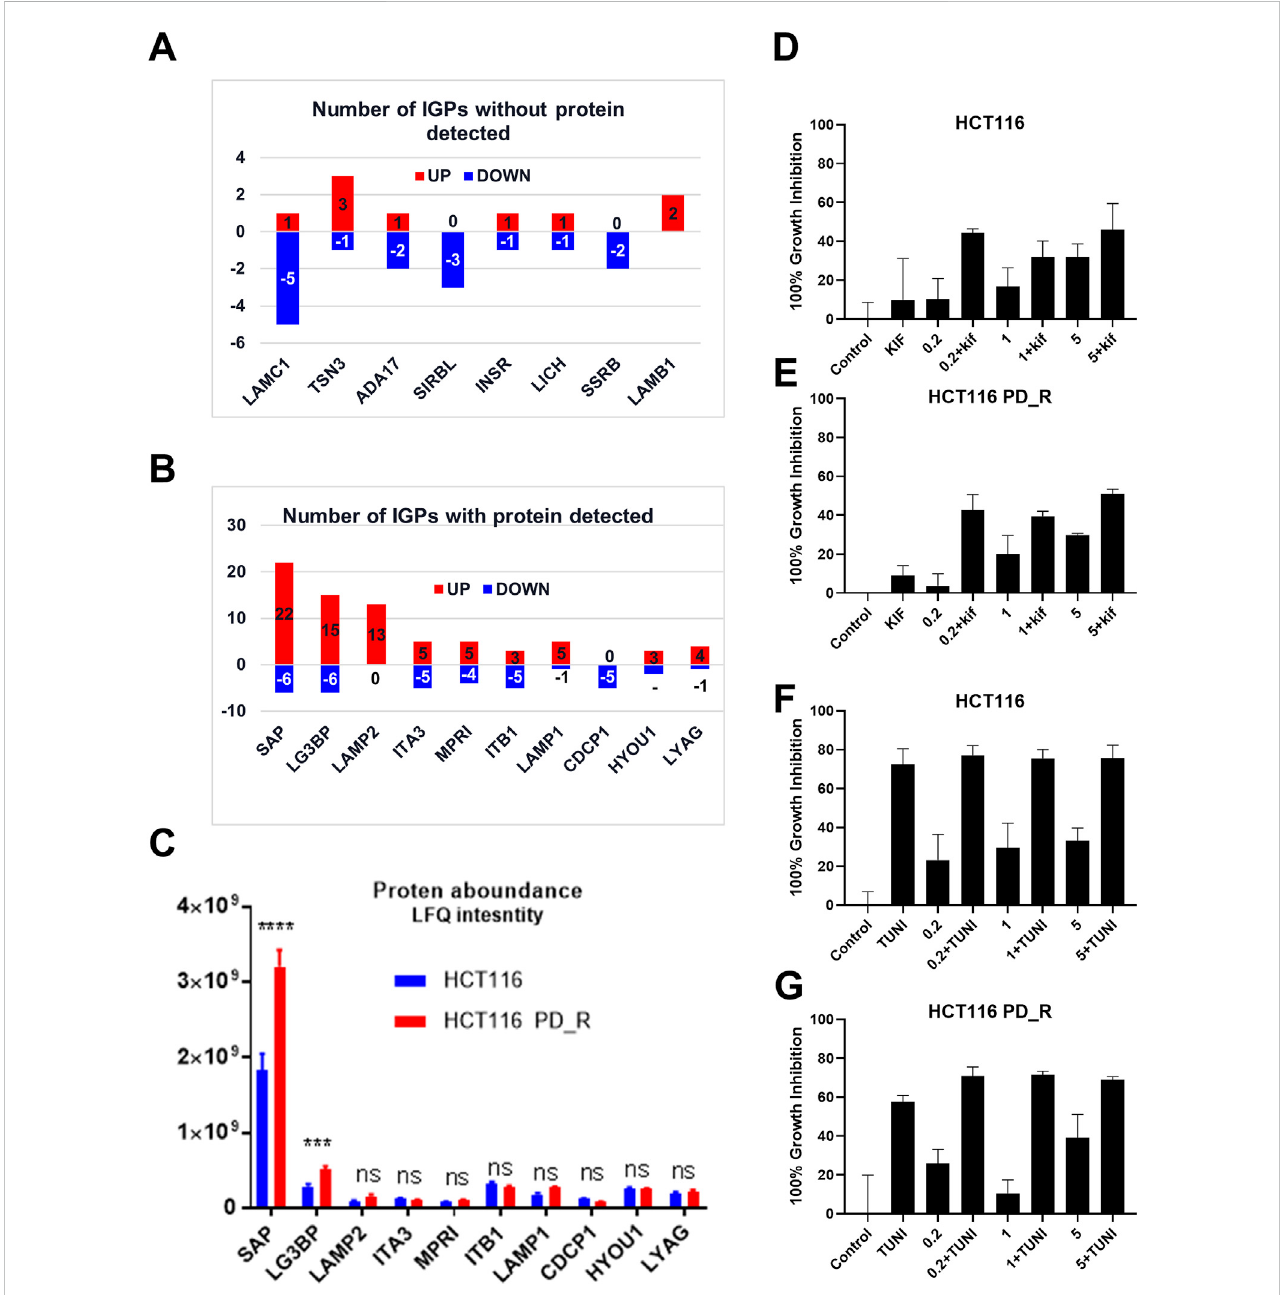
FIGURE 6 Integration analysis of proteomics and glycoproteomics. (A) Number of IGPs for N-glycoproteins exclusively identi fi ed in glycoproteomics studies. Red columns represent the numbers of the IGP with upregulation in HCT116 PD_R versus HCT116. The Blue column below the x -axis represents the downregulated numbers. (B) Number of IGPs for N-glycoproteins that were also identi fi ed in proteomic analysis. (C) The original protein abundance LFQ intensities of corresponding glycoproteins as shown in Figure (B) . (D,E) Growth inhibition of the combination treatment of kifunensine (30 μ M) and palbociclib (0.2, 1, 5 μ M) to HCT116, and HCT116 PD_R cells. (F,G) Growth inhibition of the combination treatment of tunicamycin (0.1 μ M) and palbociclib (0.2, 1, 5 μ M) to HCT116, and HCT116 PD_R cells. (Statistical analysis was performed by Graphpad Prism 8.0, and the Two-Way ANOVA multiple comparisons were applied within each row. The signi fi cance of the differences was presented by starts: **** means p -value < 0.0001, *** means p -value < 0.001, ** means p -value < 0.01, * means p -value < 0.05, ns means no signi fi cant